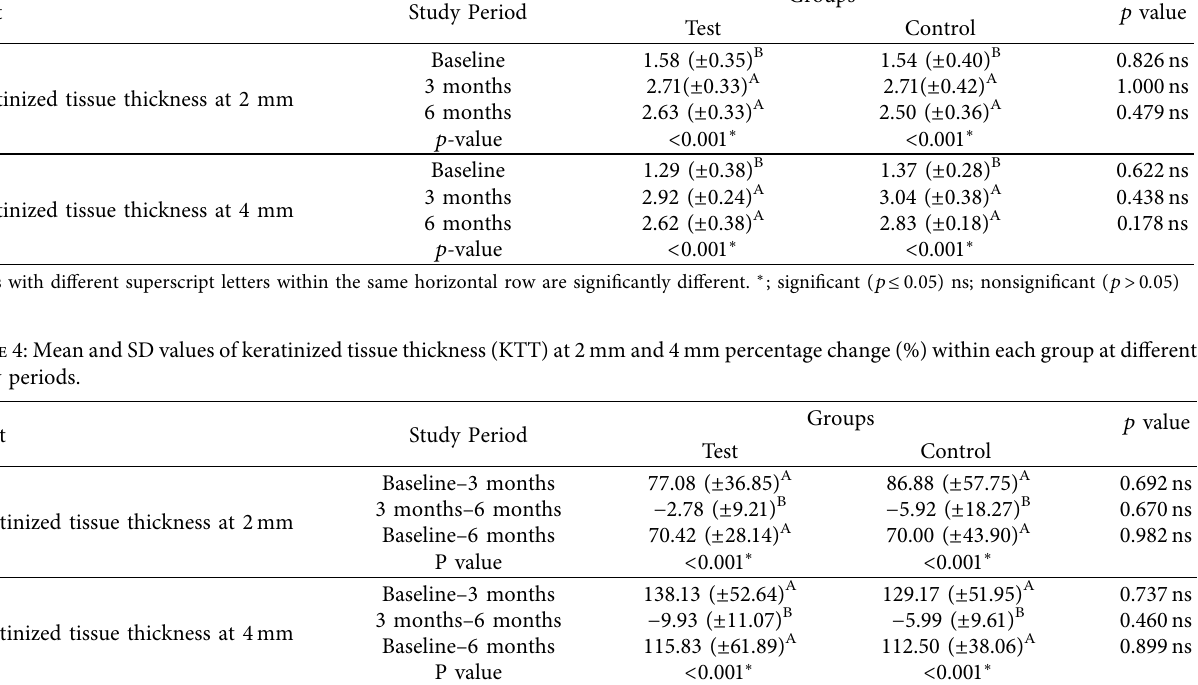
Table 3: Mean and SD values of keratinized tissue thickness at 2mm and 4 mm within each group at different study periods. Point